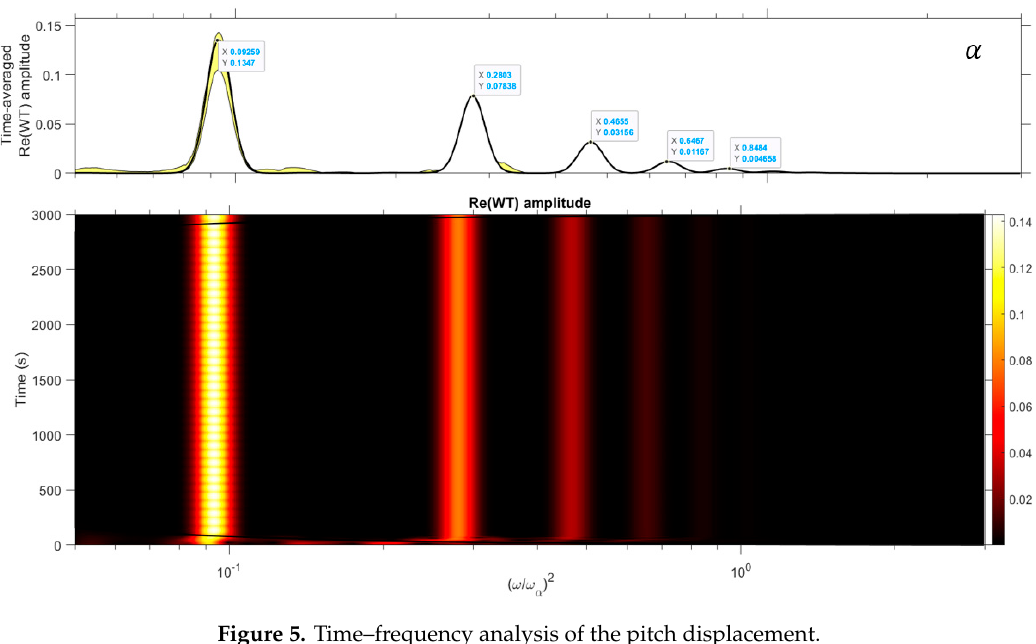
Figure 5. Time–frequency analysis of the pitch displacement.